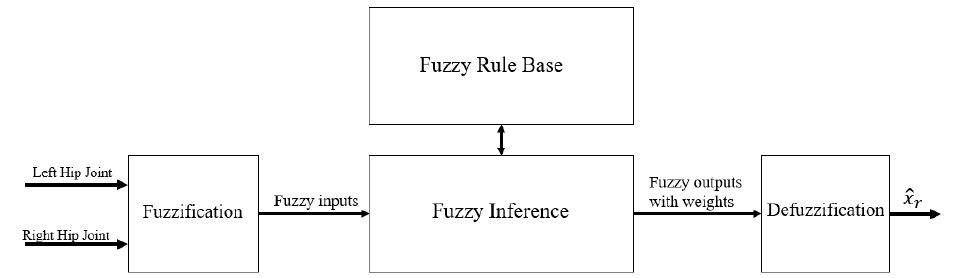
Figure 4. Schematic diagram of the overall fuzzy logic algorithm.